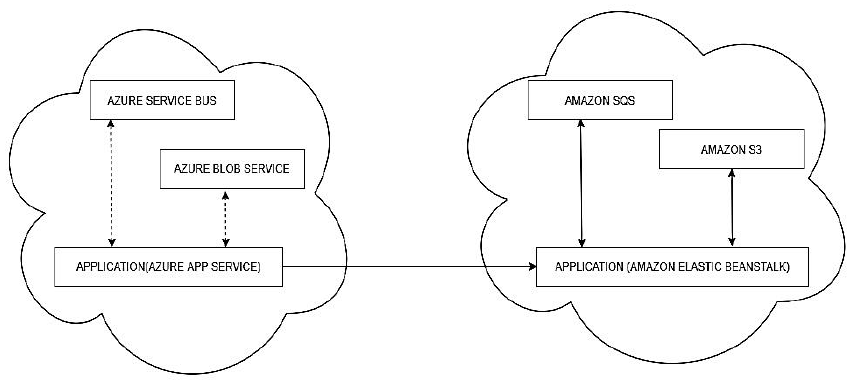
Figure 5. Cloud-to-cloud scenario.